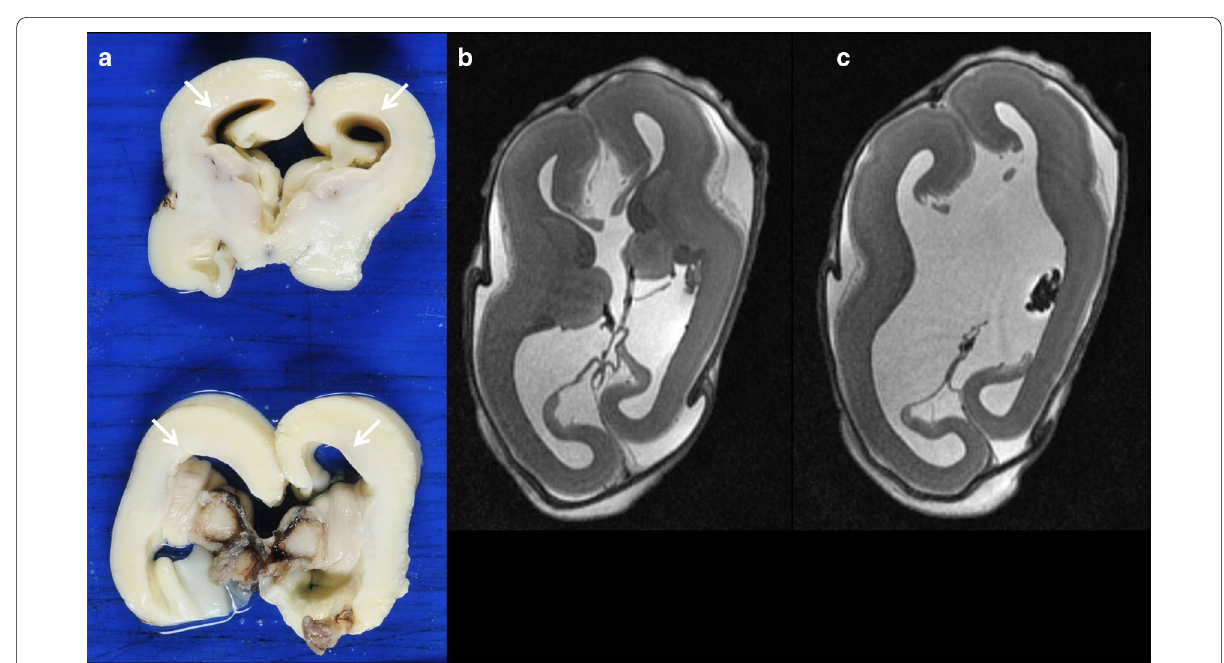
Fig. 7 Ventriculomegaly in a 21‑week foetus with elective termination of pregnancy due to CMV infection. a Pathology specimen showing ventriculomegaly (arrows) and absence of the corpus callosum, ( b , c ) axial T2W MRI demonstrating the same findings